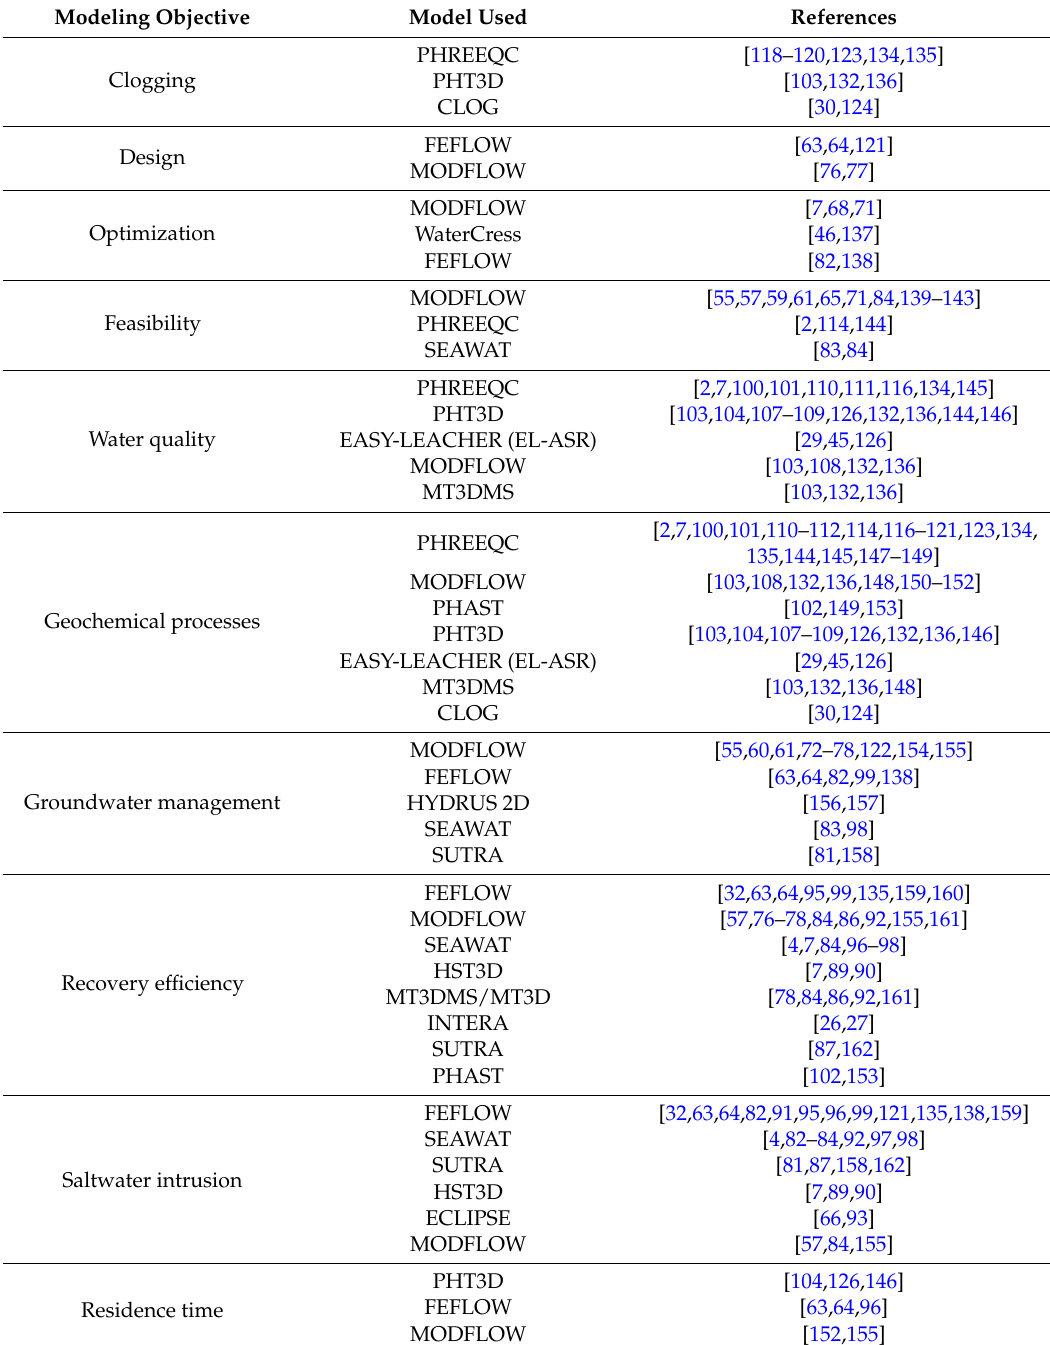
Table 3. List of models which were applied more than once for the different modeling objectives for the MAR technique well, shaft and borehole